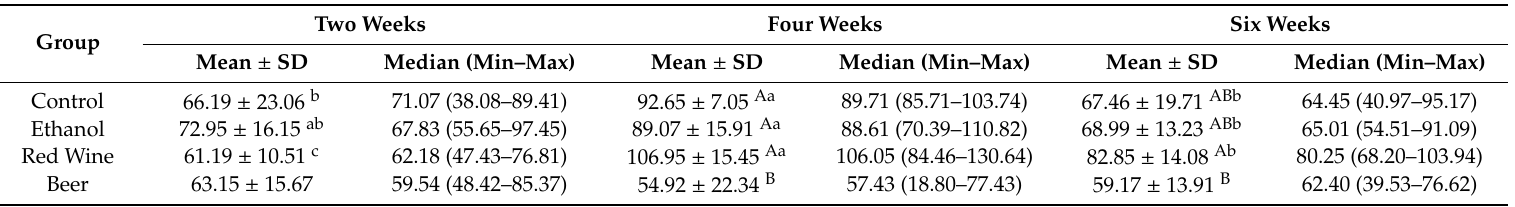
Table 12. Glutathione (GSH) level ( µ M per mg protein) in the groups of experimental rats stratified by a group and experiment duration. Group